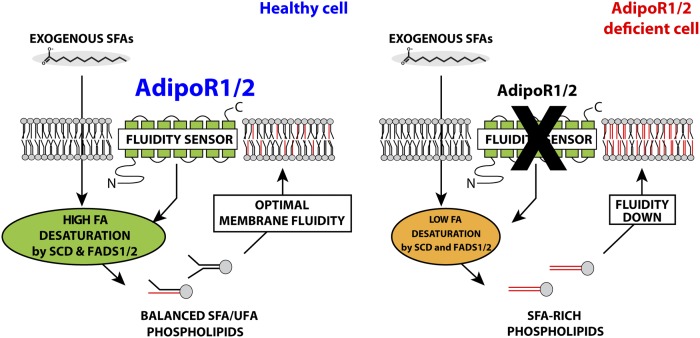
Model for the role of the AdipoRs in membrane homeostasis. In healthy cells challenged with exogenous SFAs, the AdipoRs sense membrane rigidification and signals to promote desaturase enzyme expression, resulting in increased incorporation of fluidizing UFAs into phospholipids. AdipoR-deficient cells fail to promote desaturase activity to compensate for the exogenously provided SFAs that become incorporated into phospholipids, leading to membrane rigidification and hence lipotoxicity.